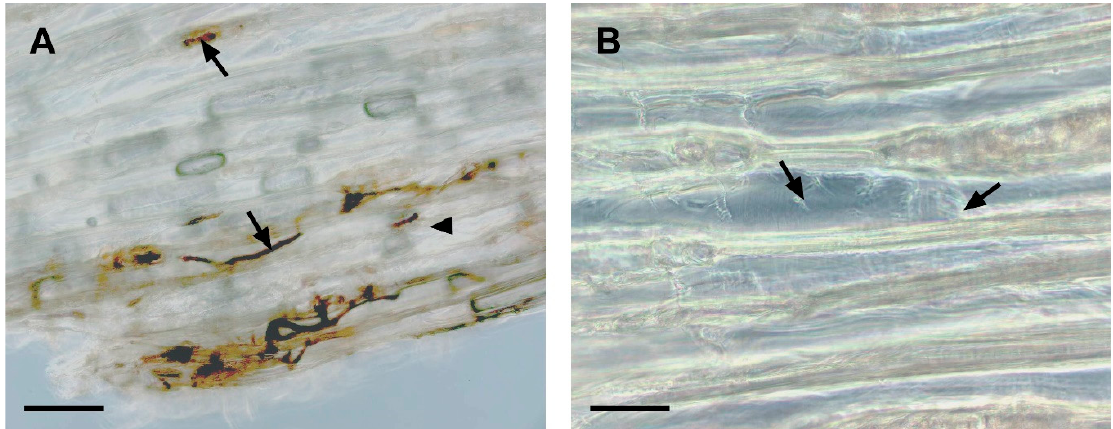
Figure 5. ( A ). Wood sections (270 µm from surface) taken from untreated, but BCA inoculated, wafers before S. sapinea inoculation. Arrows indicate melanised hyphae of S. sapinea . Bar = 20 µm. ( B ) Wood section (90–180 µm from surface) taken from wafers treated with BCA before inoculation with S. sapinea . Arrows indicate hyphae. Bar = 20 µm.